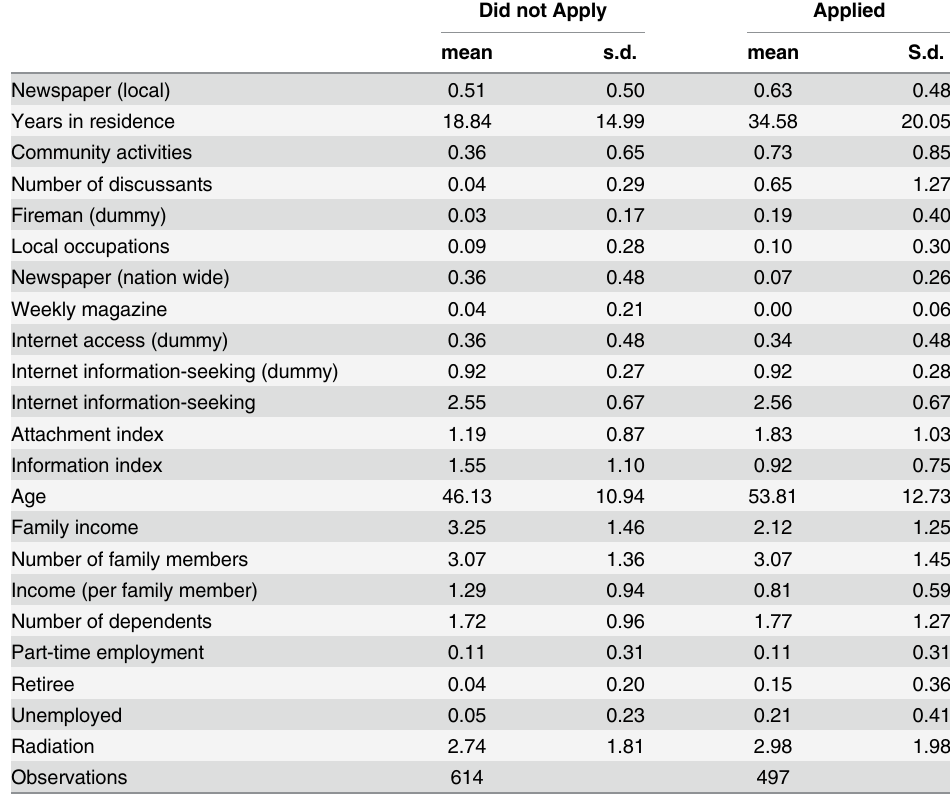
Table 1. Summary statistics: by applied and did not apply.